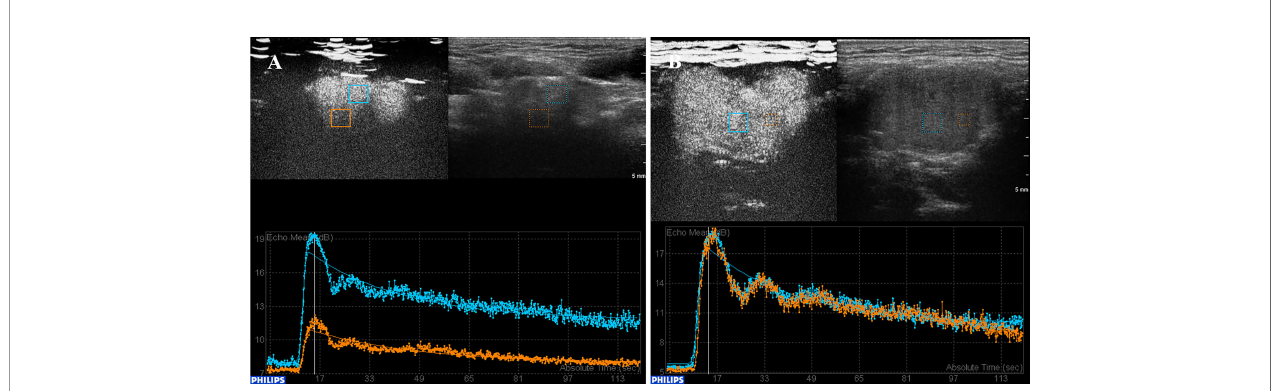
FIGURE 3 | TIC analysis of CBT lesions with heterogeneous and homogeneous enhancement. (A) TIC analysis revealed a heterogeneously enhanced lesion. The lesion showed a fast wash-in, slow wash-out, with high peak intensity enhancement pattern. (B) A homogeneous enhancement lesion area. CBT, carotid body tumor; TIC, time – intensity curve.